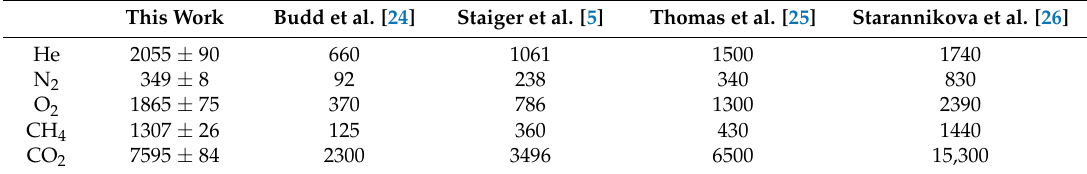
Table 2. Gas permeability (barrer) in the original PIM-1 membrane at 35 ◦ C, along with literature values.